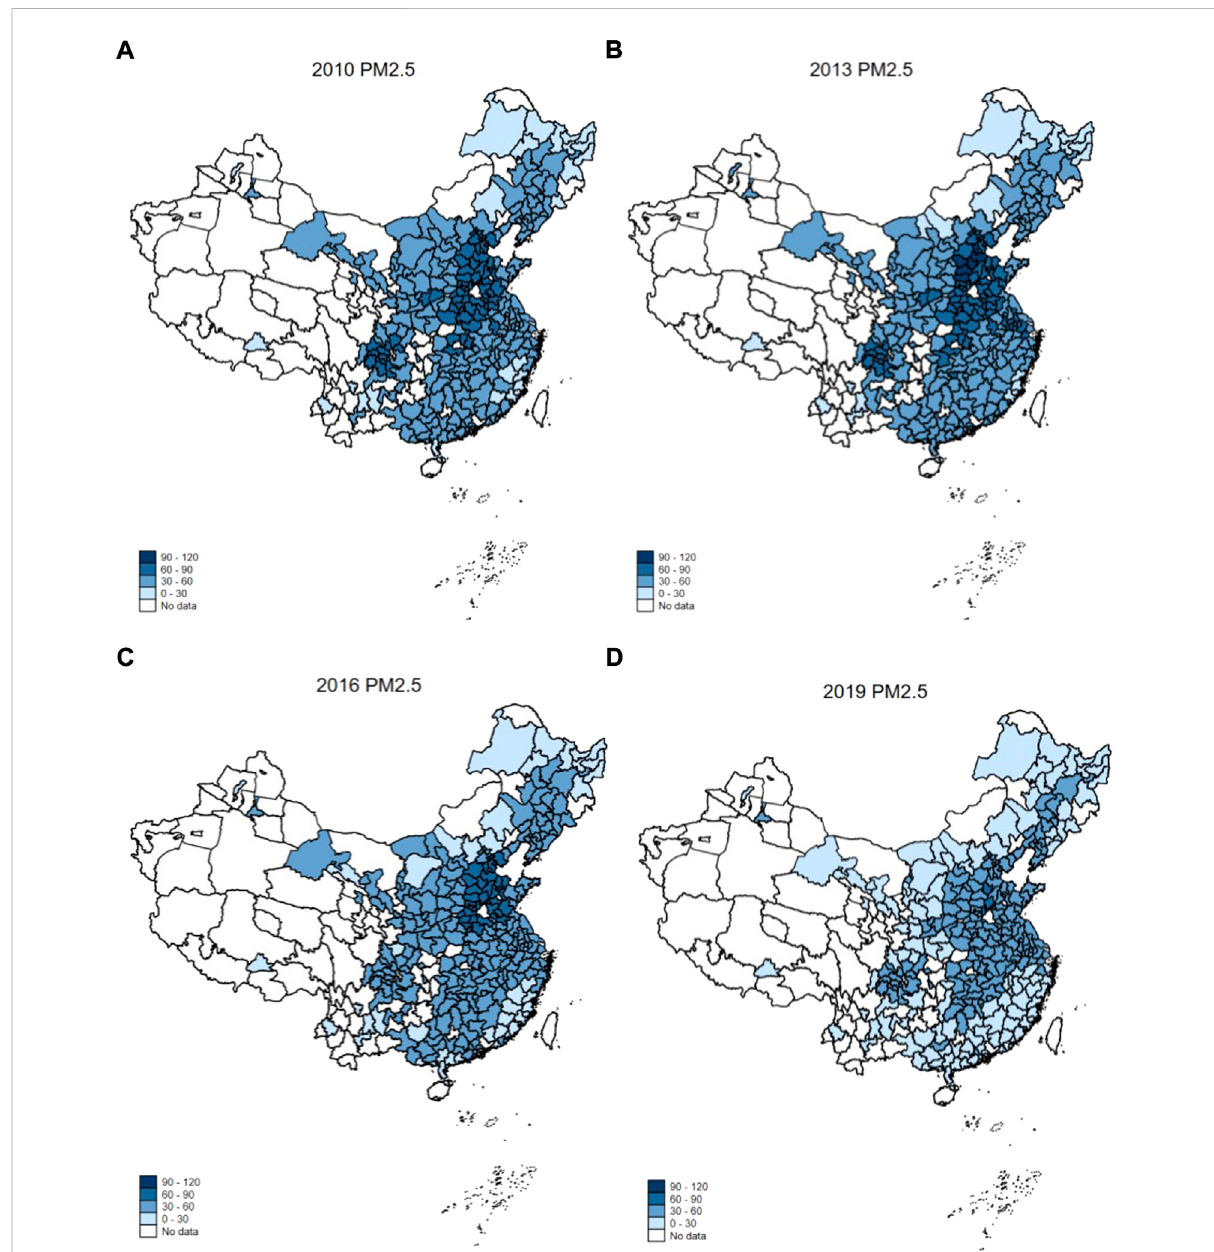
FIGURE 1 DistributionofPM2.5inChina. (A) PM2.5distributionin2010. (B) PM2.5distributionin2013. (C) PM2.5distributionin2016. (D) PM2.5distribution in